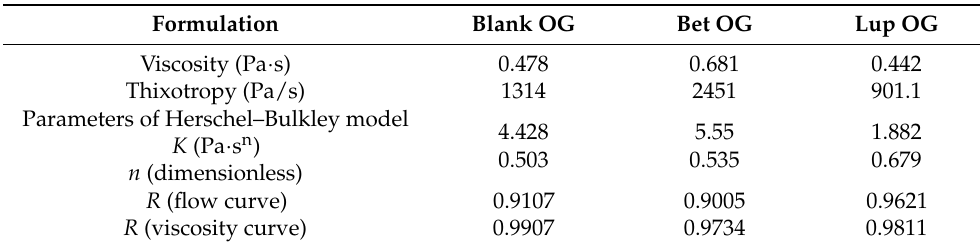
Figure 2. Flow and viscosity curves of the studied oleogels: ( A )-Blank OG, ( B )-Bet OG, and ( C )-Lup OG. Table 2. Rheological parameters (viscosity and thixotropy), parameters of the Herschel-Bulkley model describing the flow curve ( K and n ) and Pearson’s correlation coefficient ( R ).